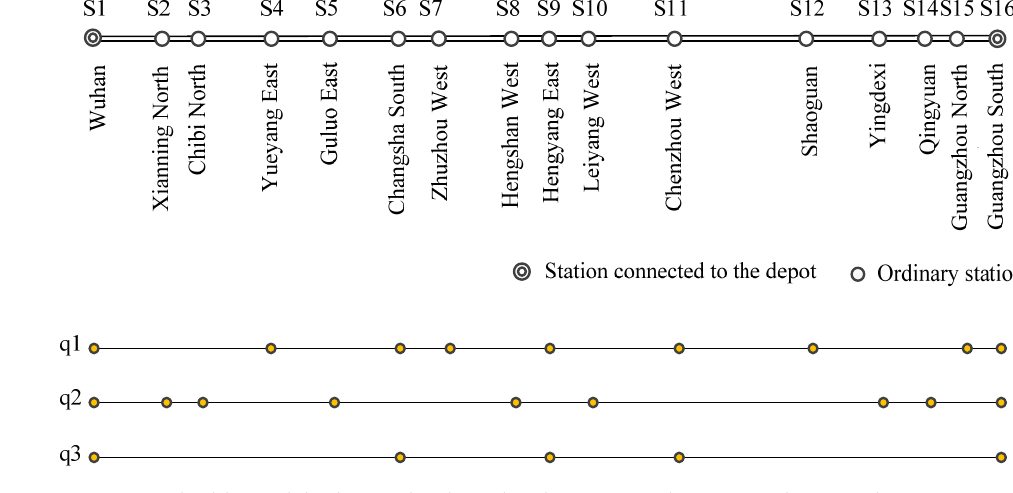
Figure 5. A double-track high-speed railway line between Wuhan city and Guangzhou city.